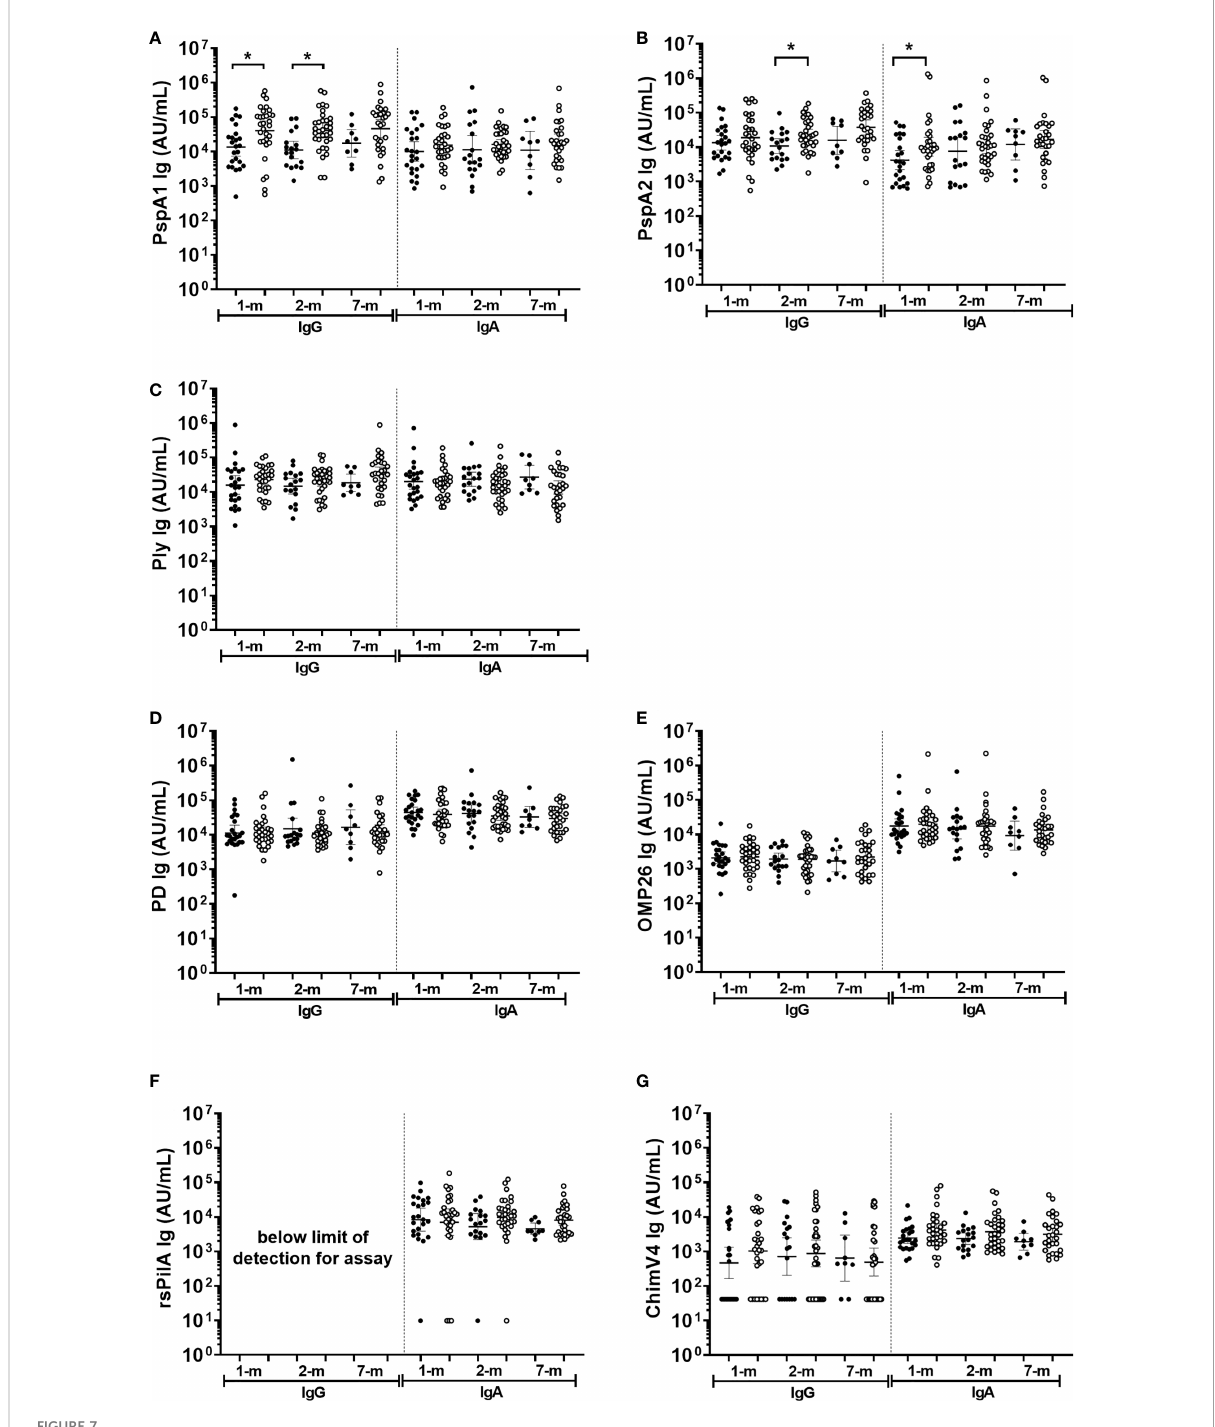
FIGURE 7 Breast milk IgG and IgA antibodies against Streptococcus pneumoniae and Haemophilus in fl uenzae antigens separated based on otitis media diagnosis in the fi rst 7-months of life or not. Each point represents breast milk IgG or IgA titres against S. pneumoniae antigens (A) PspA1, (B) PspA2, (C) Ply and H. in fl uenzae antigens (D) PD, (E) OMP26, (F) rsPilA, (G) ChimV4. PspA1, pneumococcal surface protein A family 1; PspA2, pneumococcal surface protein A family 2; Ply, pneumolysin. PD, Protein D; OMP26, outer membrane protein 26; rsPilA, recombinant soluble pilus A protein; ChimV4, chimeric vaccine antigen 4 (rsPilA and P5). Unpaired t-tests were conducted on logarithmically transformed data with * p<0.05. 1-month n=55, 2-months n=51, 7-months n=38. With otitis media= open